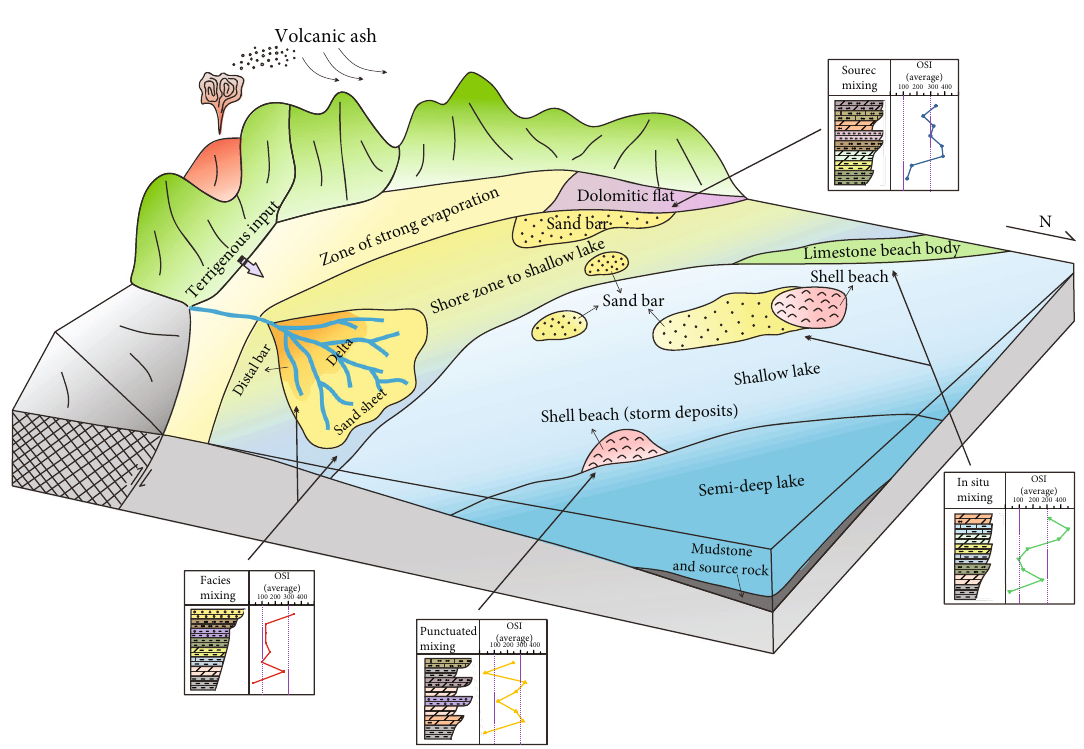
Figure 15: Generalized sedimentary model and mixing processes of the Lucaogou Formation, Jimusar Sag. Source mixing and in situ mixing areas are favorable for shale oil